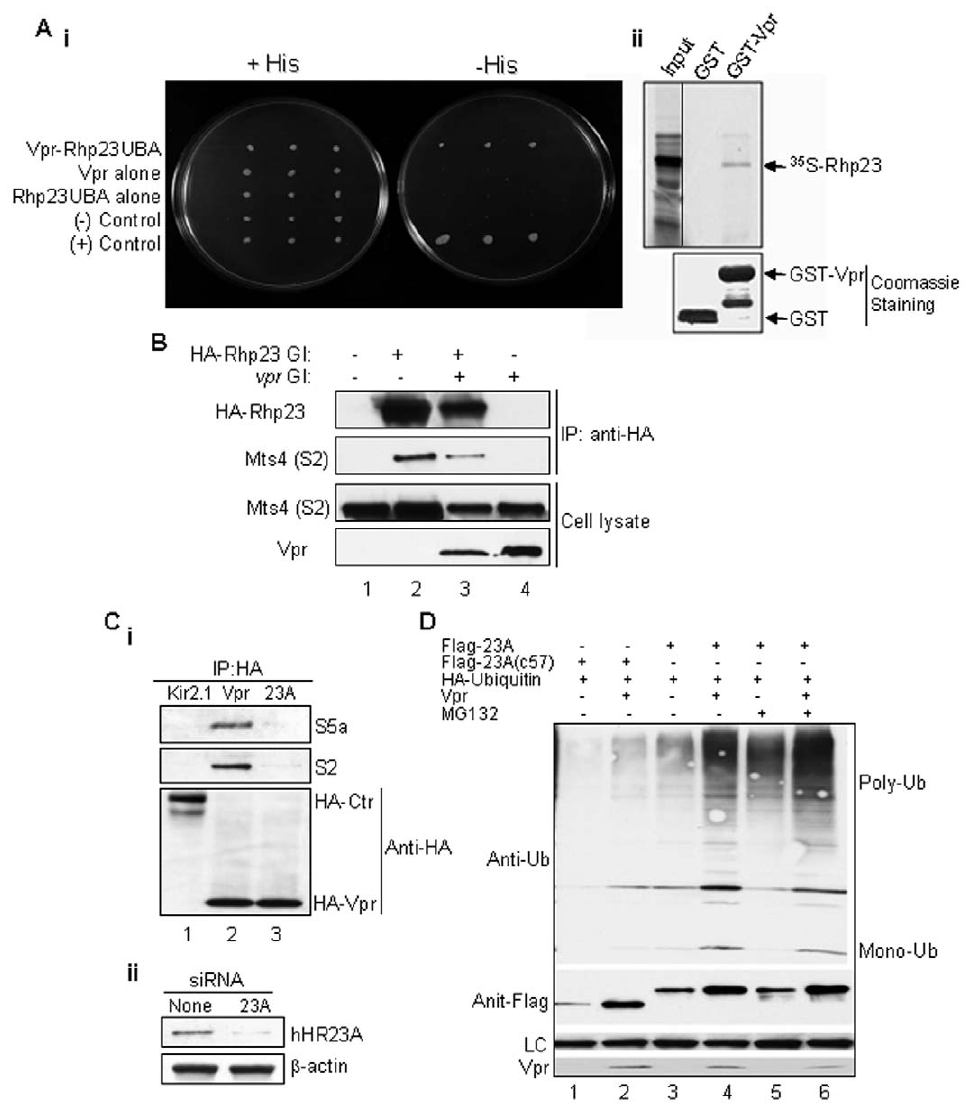
Figure 2. hHR23A is critical for Vpr-proteasome interaction. A . In vitro and in vivo interactions of Rhp23 with HIV-1 Vpr. ( i ) Rhp23, a fission yeast homologue of mammalian hHR23A[15], interacts with Vpr in the yeast two-hybrid system. The vpr gene was inserted into the pGBT9 plasmid and rph23 was fused to the activation domain in the pGAD-GH plasmid. The interaction was measured by b -galactosidase assay on cell extracts. ( ii ) In vitro interaction of Vpr with Rhp23. Bacterial cell lysates over-expressing GST and GST-Vpr proteins were immobilized on GST-agarose beads. In vitro translated 35S-labeled Rhp23 (shown by arrow) was incubated with the immobilized GST and GST-Vpr. The Coomassie staining (low panel) shows total proteins, and autoradiography (top panel) shows bound 35S-labeled Rhp23. B . Interaction of Rph23 with proteasome in the presence or absence of Vpr. HA-Rhp23-carrying plasmid was transfected into fission yeast in the presence or absence of Vpr. Following immunoprecipitation with anti-HA antibody, precipitates were tested with anti-Mts4, which recognizes the 19S regulatory subunit of the proteasome. C . i . Depletion of hHR23A abolished the interaction of Vpr with proteasome in HeLa cells. The HA-Vpr or HA-Kir2.1 (control) expressing vectors were transfected into HeLa cells with (lane marked 23A) or without hHR23A depletion by siRNA. The HA-tagged proteins were pulled down by anti-HA antibody, and then blotted with anti-S2 and anti-S5a antibodies, which recognize S2 and S5a, respectively, of the 19S regulatory subunits of the proteasome. ii . 50 m g of supernatants from lanes 2 (None) and 3 (23A) of a were blotted with anti-Rad23A or b -actin antibody. D . Vpr promotes protein poly-ubiquitination via hHR23A. Flag-tagged hHR23A was co-expressed with HA-ubiquitin in the presence or absence of Vpr in HeLa cells. Forty-eight hours after transfection, cells were collected and cell extracts were subject to Western blot analysis using indicated antibodies. hHR23(c57) is a non-functional mutant derivative of hHR23A [43]. MG132 was used to inhibit the proteasome activities.